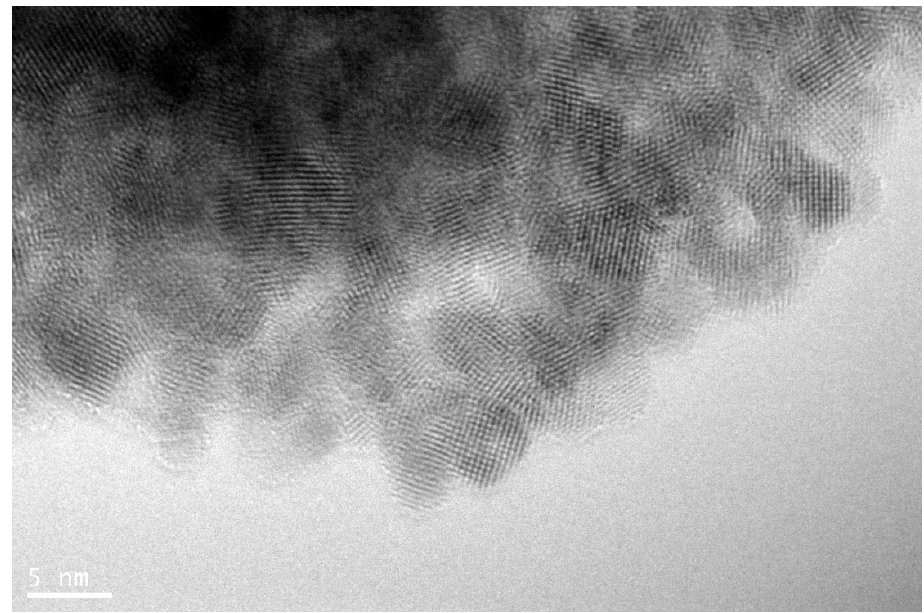
Figure 9. TEM image of TiO 2 nanoparticles.